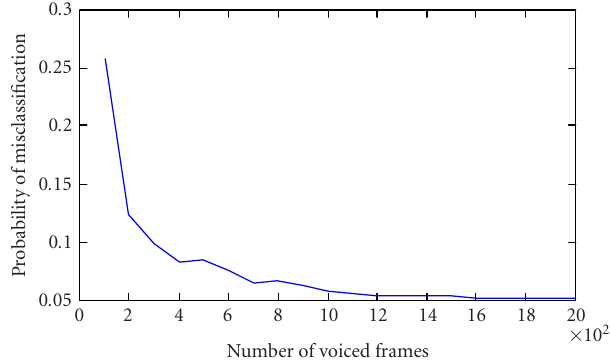
Figure 5: Probability of misclassification versus the number of clus- ters for 110 speakers.